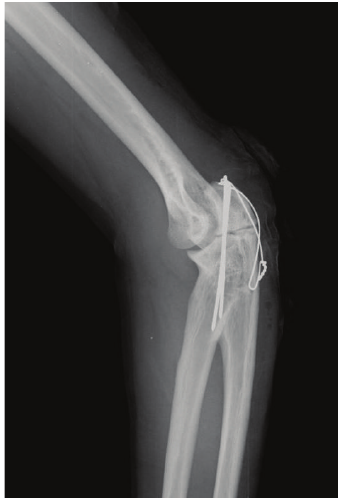
Figure 5: Young adult male with history of Rothmund-Thomson syndrome diagnosed at 2 years of age. Findings: there is satisfactory alignment of the olecranon fracture after tension band wiring. Technique: lateral radiograph kVp = 60, mAs = 3.